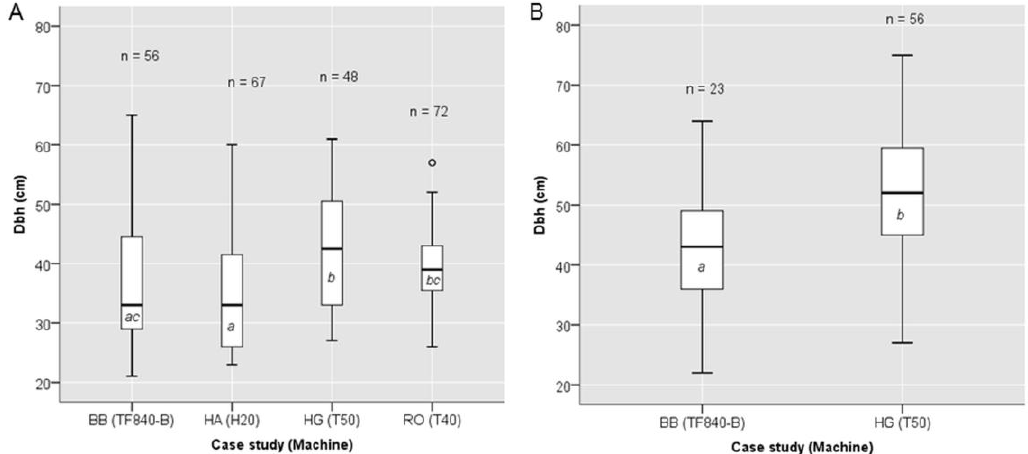
Figure 2. Boxplots of tree diameter at breast height (dbh) distributions in the individual case studies in the fully-mechanized (FM) ( A ) and motor-manual (MM) ( B ) groups. Bad Brückenau (BB), Hammelburg (HA), Heigenbrücken (HG), Rothenbuch (RO). Different letters indicate significant differences in dbh between case studies ( p < 0.05).